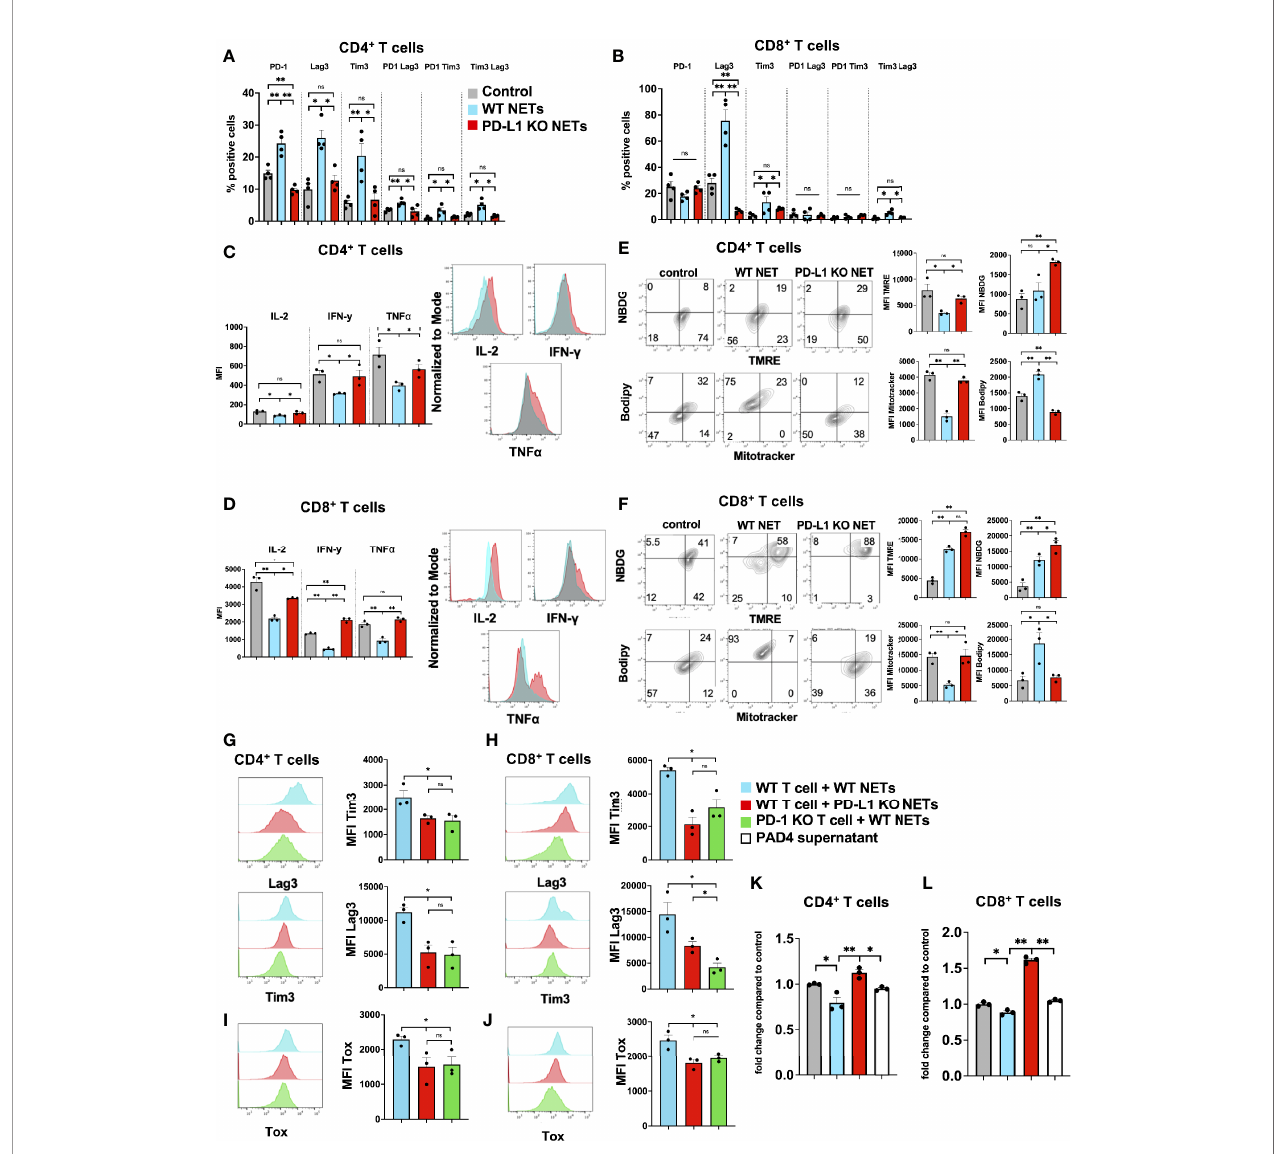
FIGURE 6 | PD-L1 within NETs causes phenotypic, metabolic and functional T cell exhaustion in vitro. Splenic CD4 + and CD8 + T cells were pretreated with CD3/28 beads and then cultured for 72h in the presence of isolated WT or PD-L1 KO NETs. (A, B) Markers for T cell exhaustion were analyzed by fl ow cytometry were signi fi cantly upregulated on T cells in the presence of WT NET but not PD-L1 KO NETs. (C, D) T cell intracellular cytokines were analyzed by fl ow cytometry following fi xation and permeabilization. T cells in the presence of WT NETs expressed signi fi cantly lower levels of intracellular cytokines compared to PD-L1 KO NETs. (E, F) Similarly, following culture with WT NETs, T cells were stained with metabolic markers, showing decreased mitochondrial activity, decreased glucose but increased lipid uptake in the presence of WT but not PD-L1 KO NETs. (G, H) T cells derived from PD-1 KO mice were treated in similar fashion and cocultured with WT NETs only and analyzed from Tim3 and Lag3 expression. These cells showed similar expression levels to WT T cells cultured with PD-L1 KO NETs. (I, J) Intracellular staining for TOX was performed showing decreased expression levels in T cells + PD-L1 KO NETs and PD-1 KO T cells + WT NETs. (K, L) Proliferation of CD4 + or CD8 + T cells in the presence of WT NETs or PAD4 supernatant. Bar graphs represent mean +/- SEM of at least 2 independent experiments, performed in duplicates or triplicates. *p < 0.05, **p <